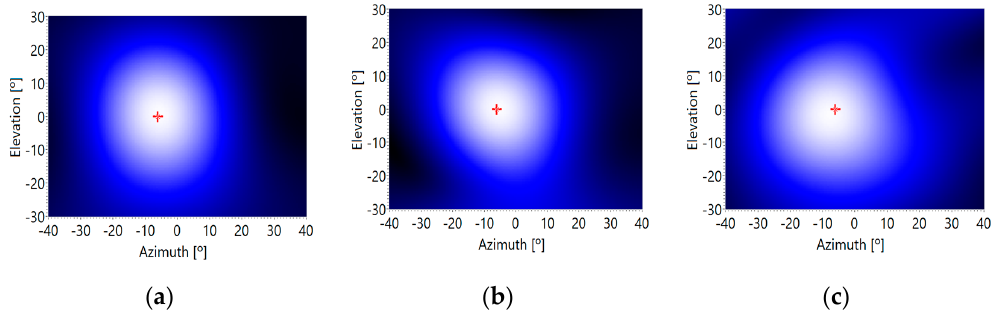
Figure 10. Acoustic image versus background noise level: ( a ) minimum, ( b ) medium and ( c ) maximum.